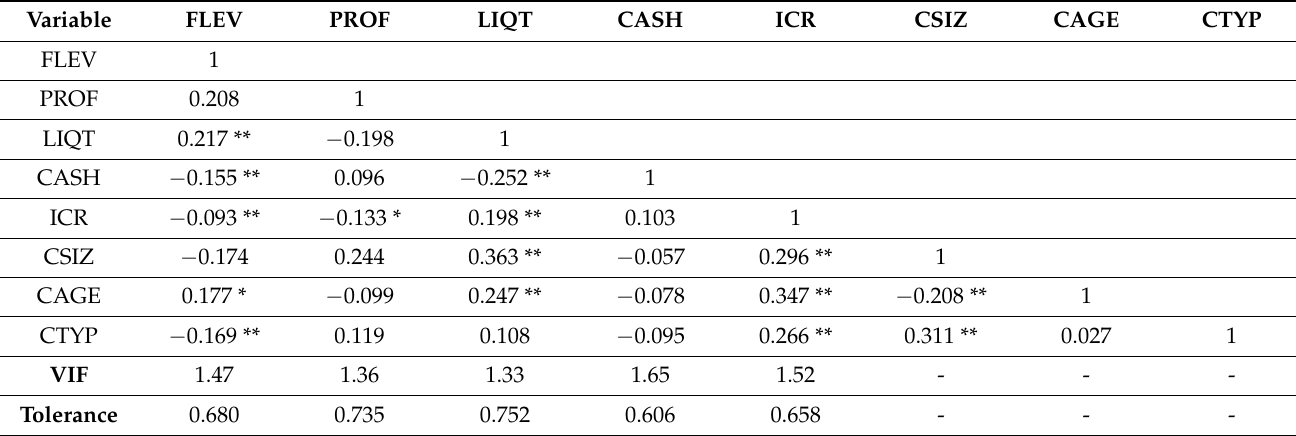
Table 6. Correlation analysis results for independent